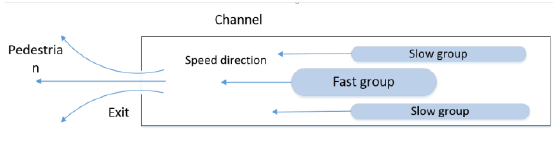
Figure 1. Speed Stratification